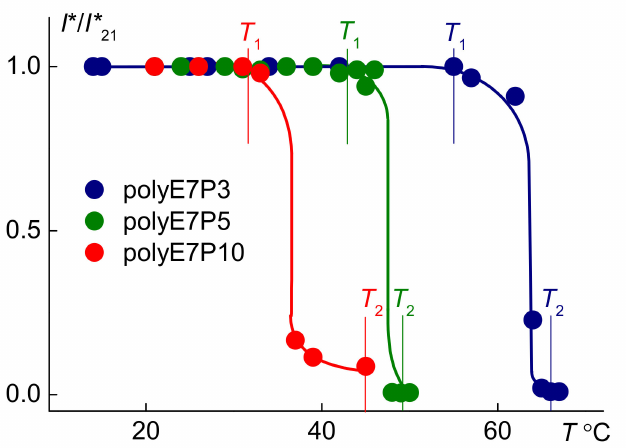
Figure 5. Temperature dependences of the relative optical transmission I */ I * 21 for the aqueous solutions of polyOEGeOPGpMA at concentration c ≈ 0.0050 g · cm − 3 . I * 21 is optical transmission at 21 ◦